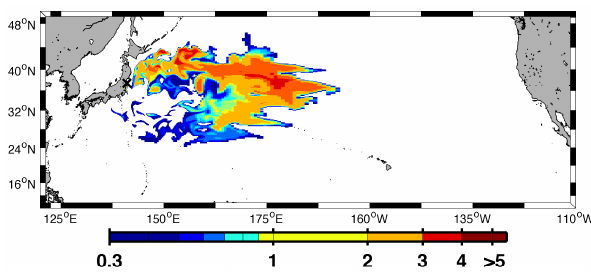
Fig. 12. Simulated (nominal year 1996 simulation) surface 137 Cs concentration in units mBql − 1 on 1 April, one year after the 137 Cs release off Fukushima Dai-ichi (indicated by the black x). Only ac- tivities, which according to Park et al. (2008), exceed the minimum detectable activity in surface waters, are shown.